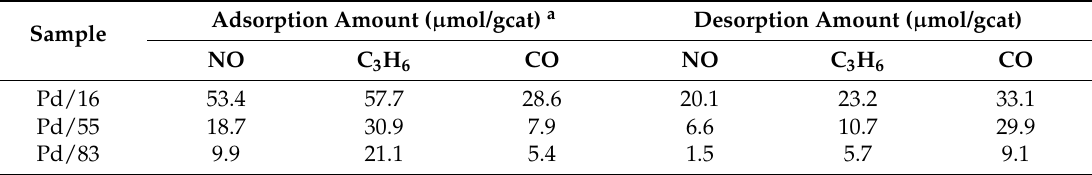
Figure 1. Catalyst evaluation of each sample ( a , c , e : the adsorption stage in O 2 , CO 2 , N 2 , H 2 O, C 3 H 6 , CO, and NO x (190 ppm NO, 10 ppm NO 2 ) at 80 ◦ C; b , d , f : the desorption stage in N 2 up to 500 ◦ C). Table 2. Adsorption amounts and desorption amounts of each gaseous